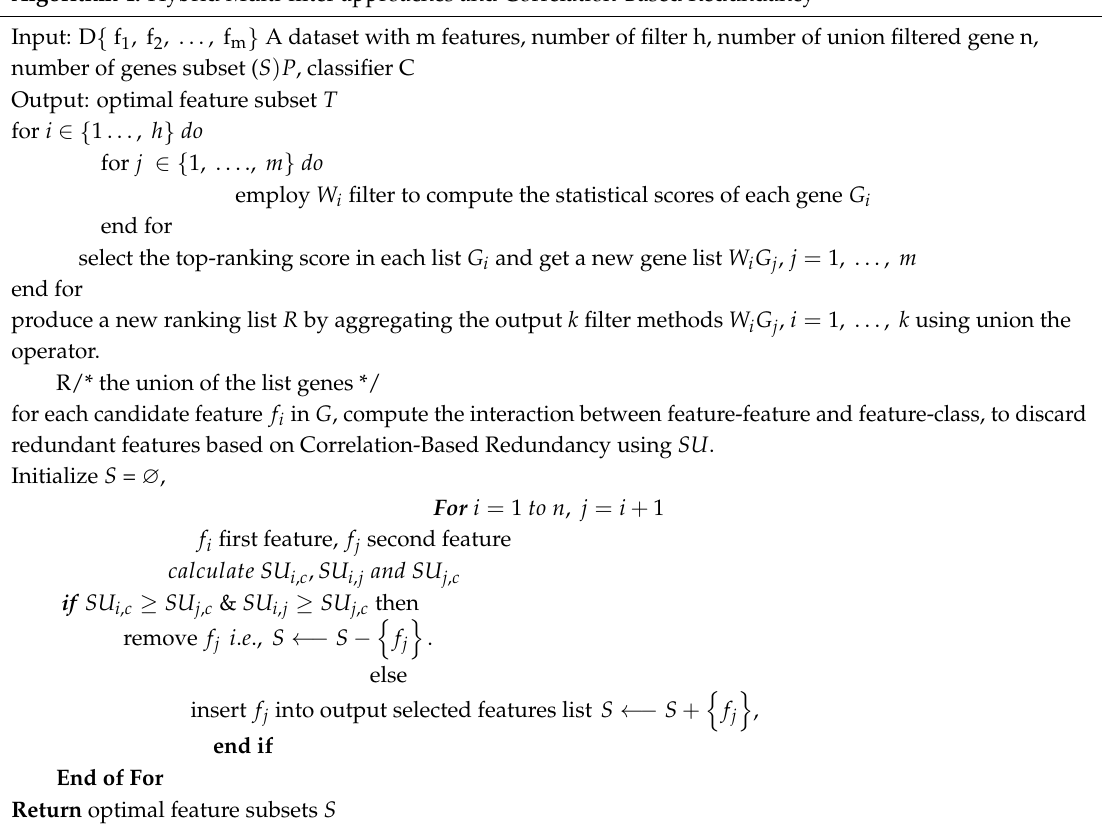
Algorithm 4. Hybrid Multi-filter approaches and Correlation-Based